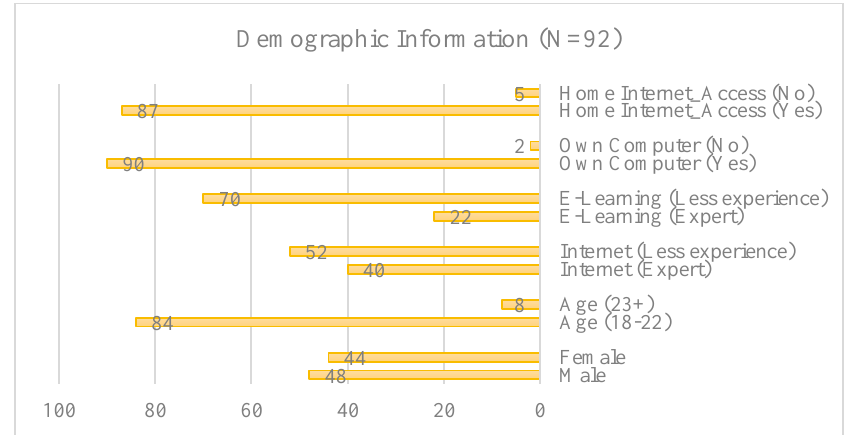
Figure 3. Profile of participants (experimental